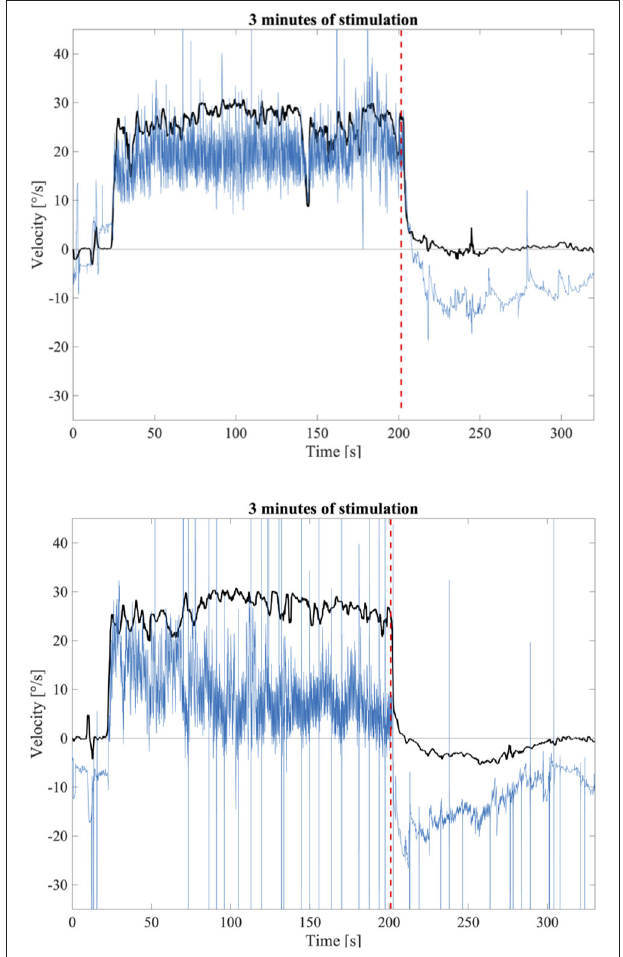
FIGURE 2 | Top: Example of a SPEV response (Black) and the eye position trace (Blue) to 3min of optokinetic stimuli without OKAN-II; Bottom: Example of a SPEV response (Black) and the eye position trace (Blue) to 3min optokinetic stimuli with OKAN-II that could be identified by visual inspection. The dashed red line indicates the instant where the light was